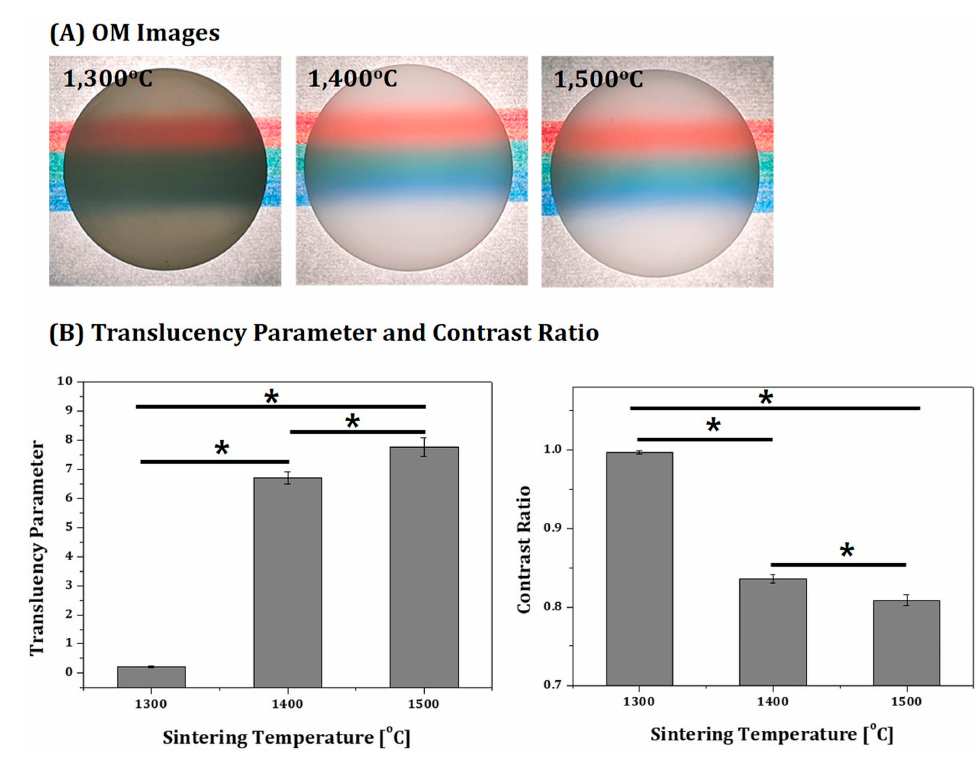
Figure 14. ( A ) Optical image of 4Y-PSZ disks sintered at various temperatures (1300 °C, 1400 °C, and 1500 °C) placed on colored lines and ( B ) their translucency (TP) and contrast ratio (CR) values (* p < 0.05).